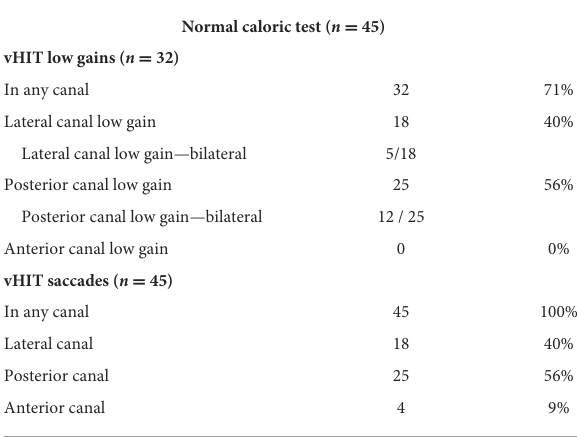
TABLE 1 Normal caloric test and abnormal vHIT